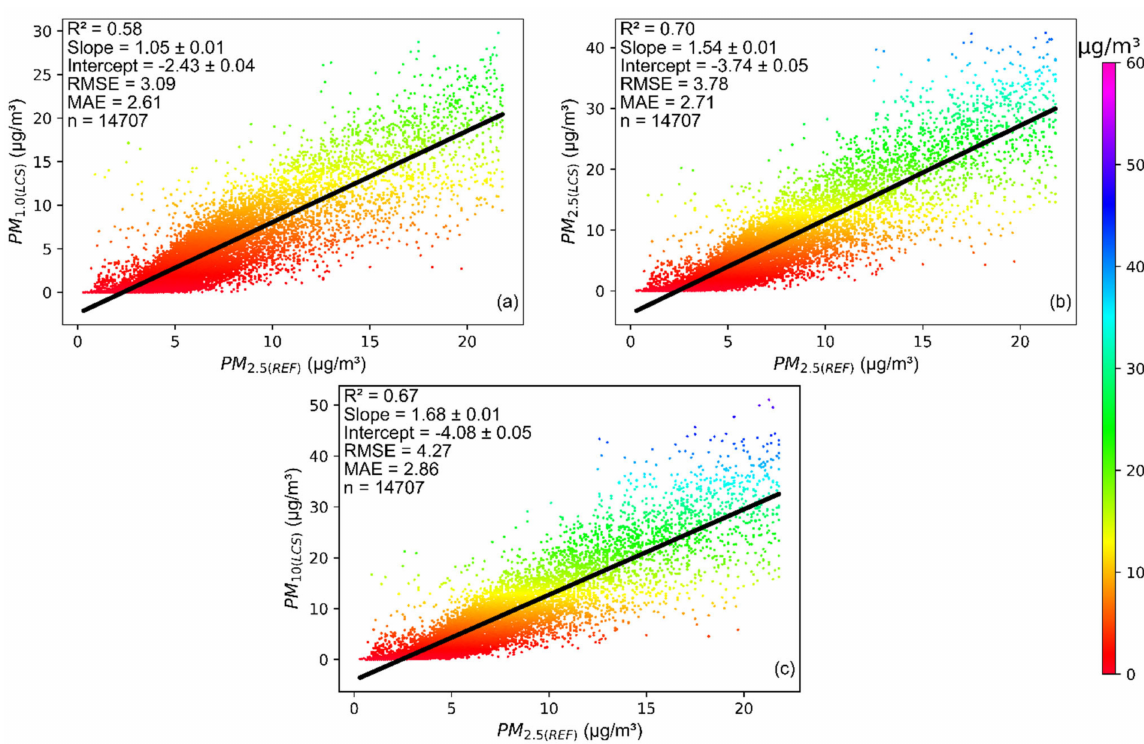
Figure 2. Comparison between PM 2.5_REF and ( a ) PM 1.0_LCS ; ( b ) PM 2.5_LCS ; and ( c ) PM 10_LCS